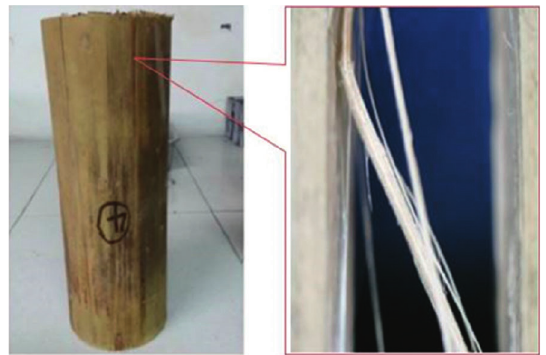
Figure 8: Final resultant image of the compression test and a microscopic view of the compressed